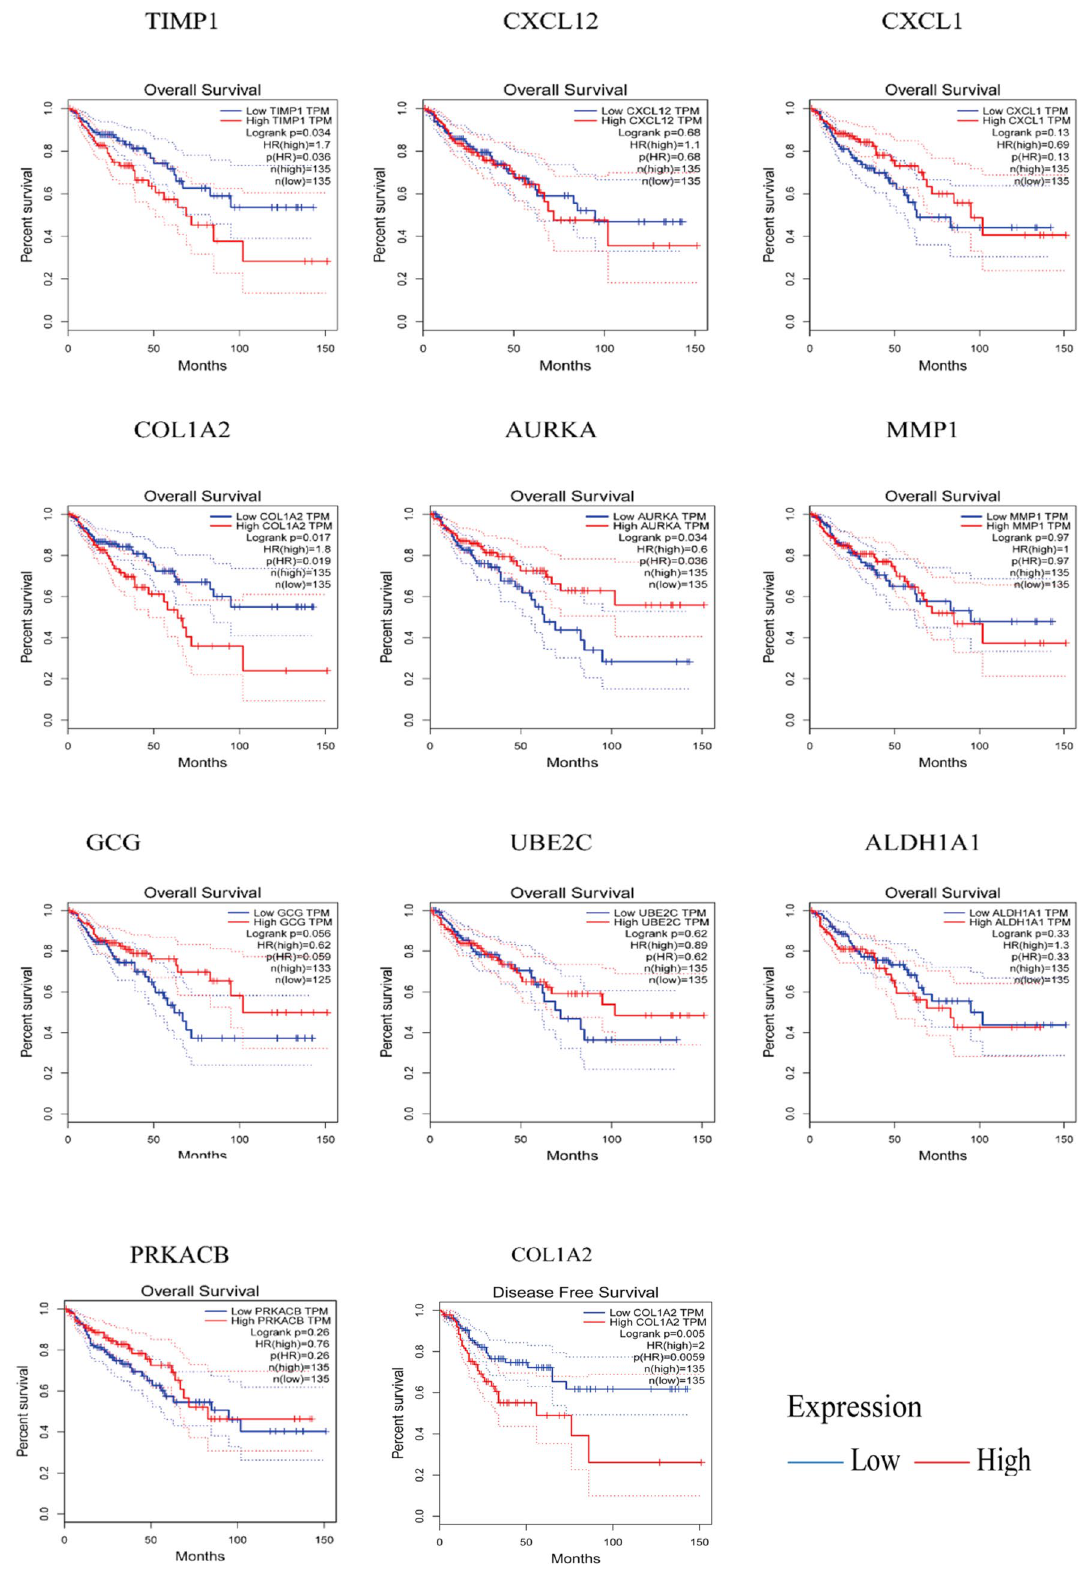
Figure 6. Kaplan–Meier survival analyses of DEGs between primary tumor tissues and normal colon tissues. Under-expression of TIMP1, COL1A2 and AURKA genes, was associated with longer overall survival. Under- expression of COL1A 2 gene was associated with longer disease-free survival of CRC patients. See Table 5 for gene